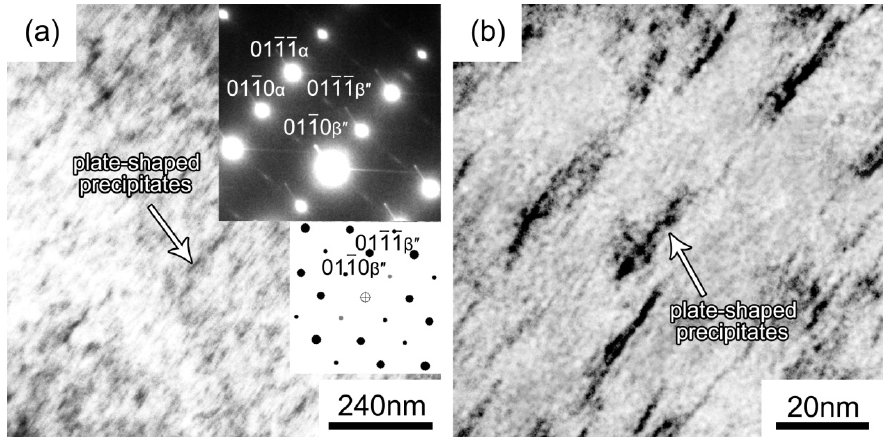
Figure 5. TEM images of specimens without pre ‐ stretching aged at 200 °C for 8 h: ( a ) plate ‐ shaped precipitates in the matrix and corresponding SAED patterns (B//[1120] α ); and ( b ) high magnification TEM image of the plate ‐ shaped precipitates.